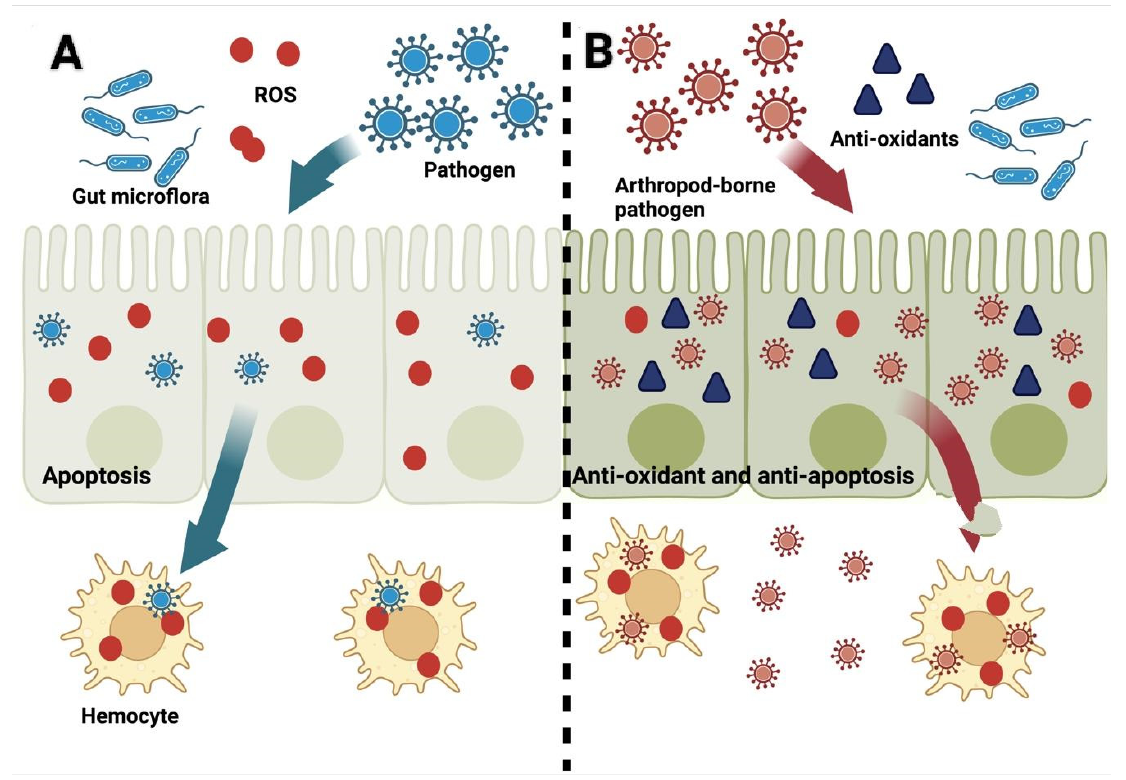
Figure 1. Schematic diagram of the life cycle of the pathogen ( A ) after infection of the arthropod versus the arthropod-borne pathogen’s ( B ) life cycle and its interaction with ROS. Created with Biorender.com (accessed on 10 May 2022).